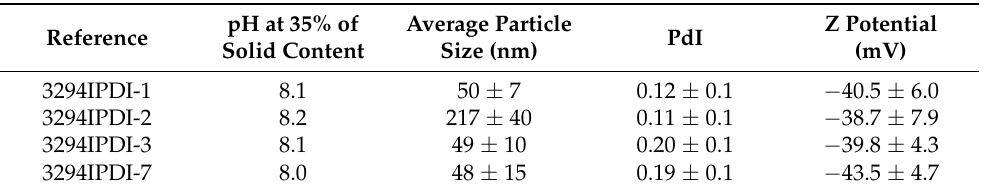
Table 7. A summary of the particle size and PdI measurements, average particle size, and Z-potential values for synthesized WPUD